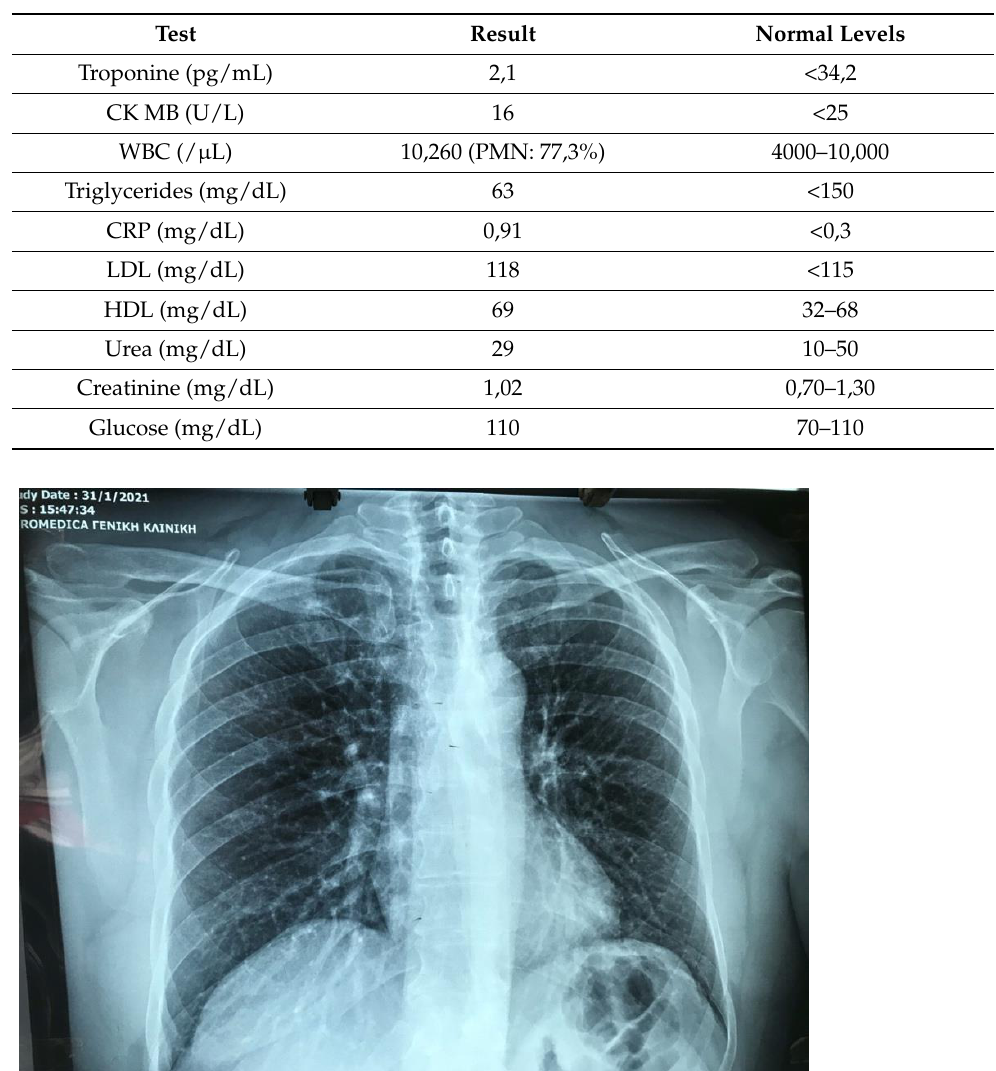
Table 1. Laboratory findings of the patient at the acute phase of the symptoms (at 6 h from the on-set).